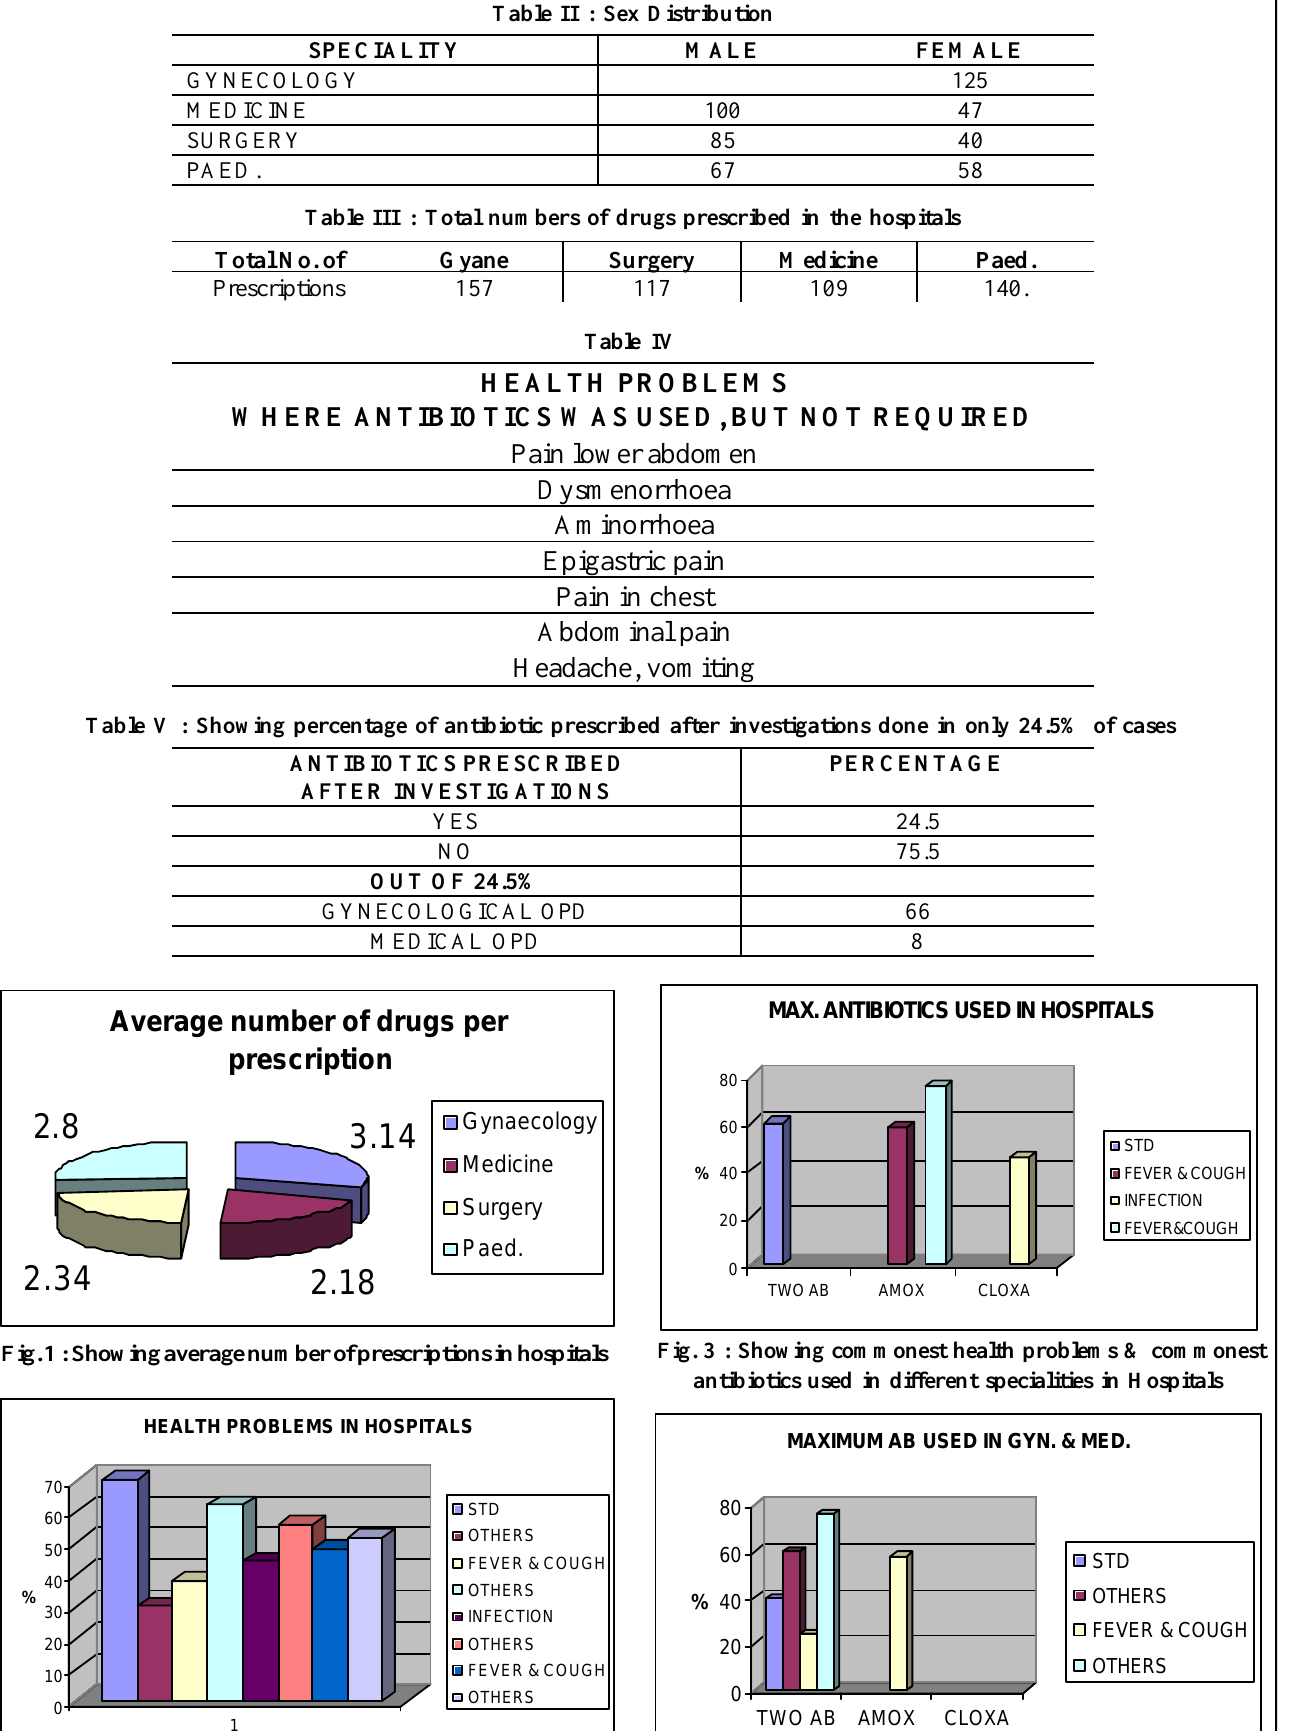
Fig. 4a : Showing antibiotics used in OPD of